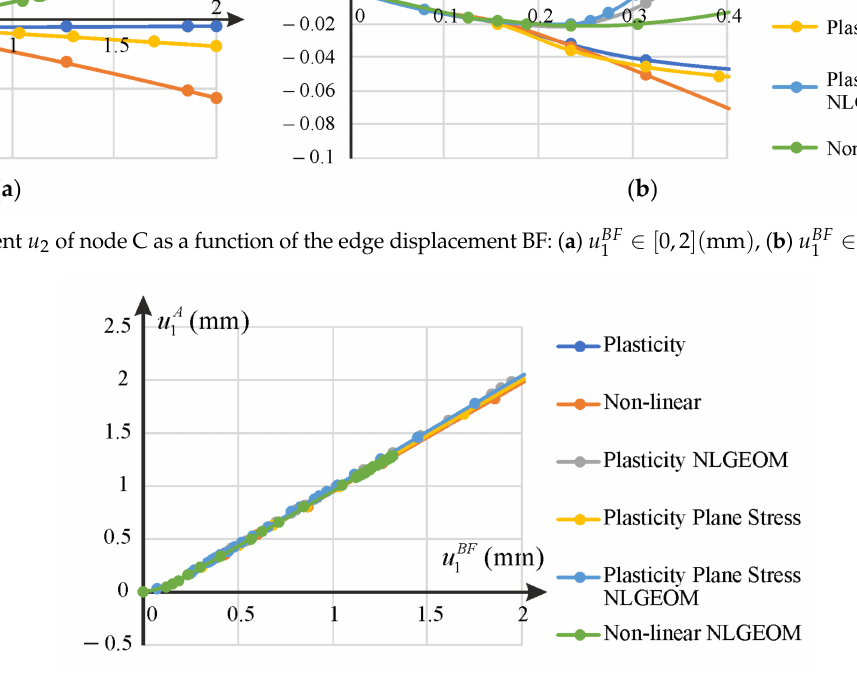
Figure 18. Displacement u 1 of node A as a function of the edge displacement BF